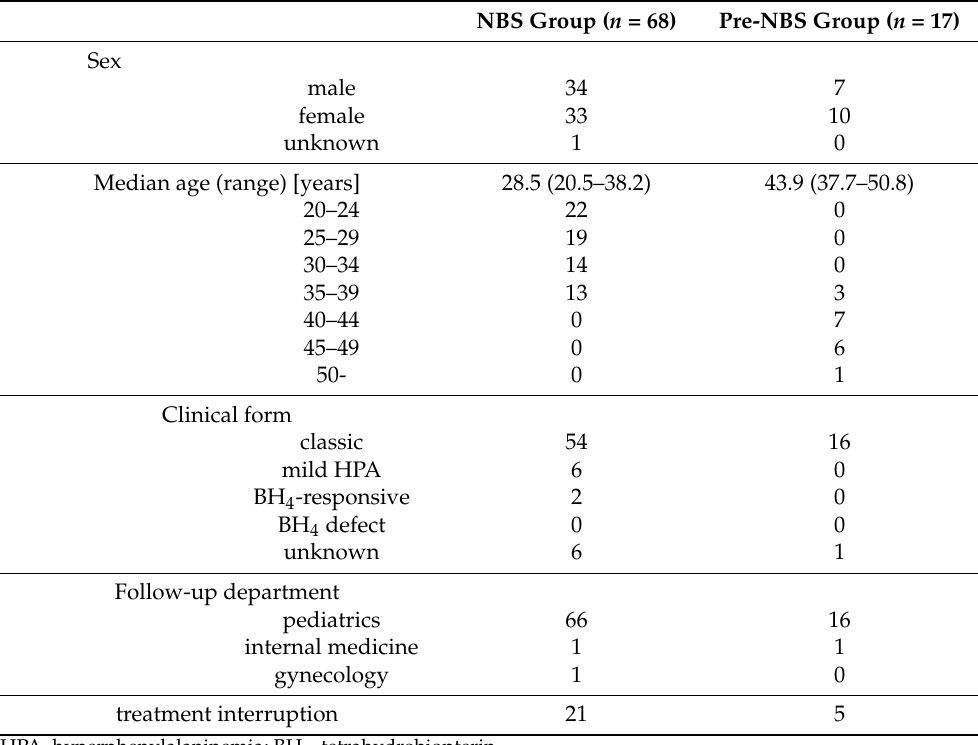
Table 1. Overview of the participating patients with phenylketonuria (PKU).